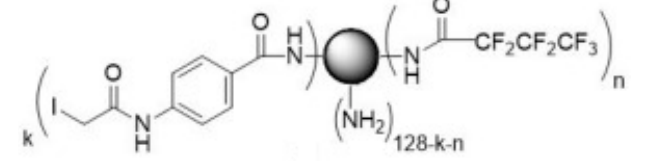
Figure 5. PAMAM G5-Sulfo-SIAB ( 3 ).